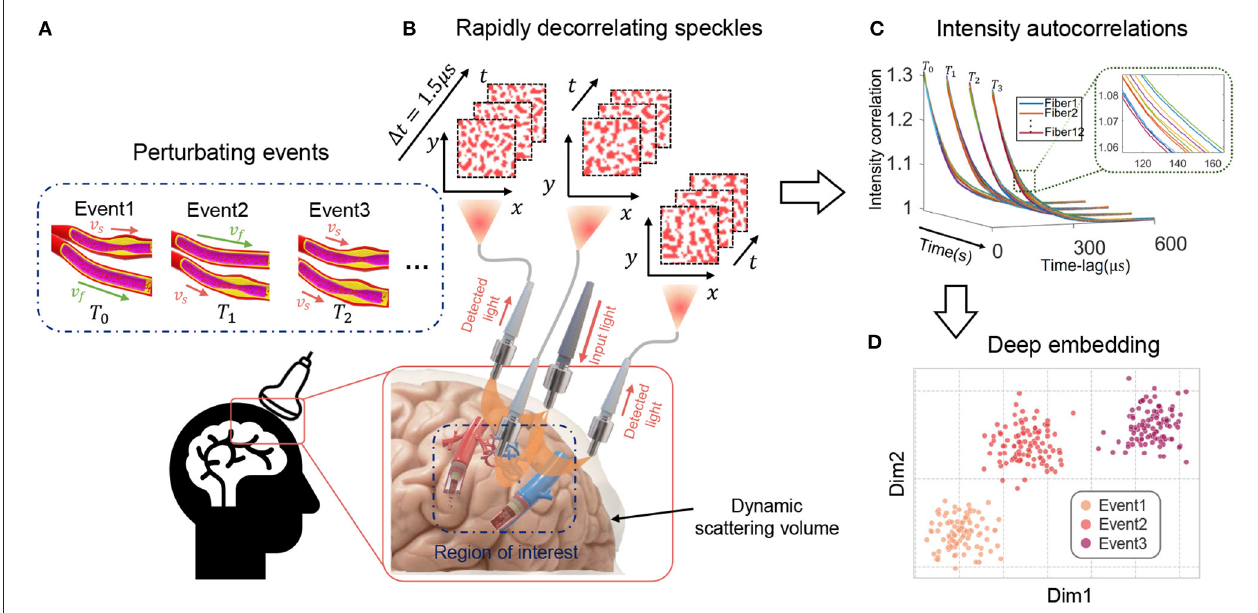
FIGURE 1 | Overview of the proposed CREPE technique for classification of events occurring many millimeters within tissue. (A) Different decorrelation phenomena (e.g., different blood vessels flowing at different speeds) deep inside tissue cause surface light speckles in (B) to change at different rates. Speckle fluctuations are collected by fibers and recorded by a SPAD array camera. Temporal intensity autocorrelations of each fiber position for every decorrelation event are computed (C) and classified (D) into different categories using a deep clustering network.